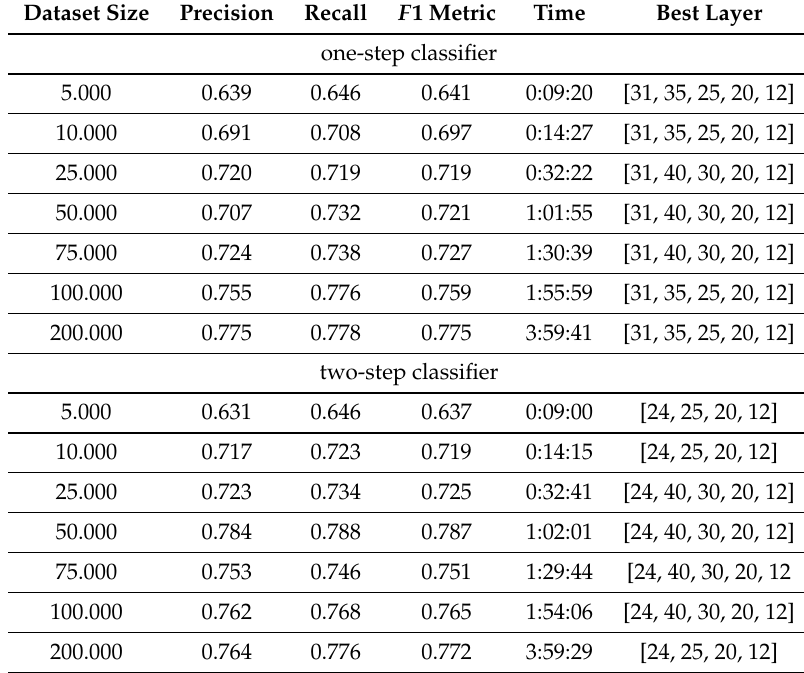
Table 14. Multilayer